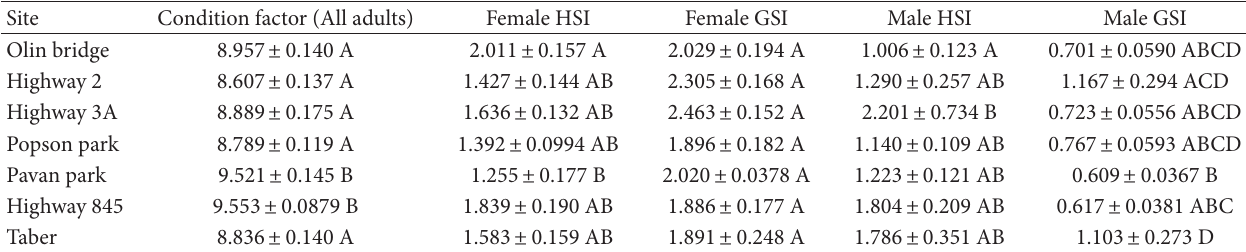
a Capital letters that are different within columns indicate statistically signi�cant differences.